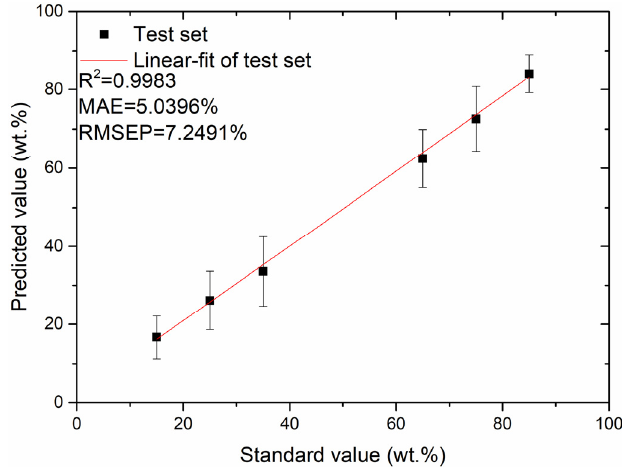
Figure 10. Plot of relationship between the predicted and standard values of the test set based on the LASSO-PLSR-SVR residual correction model. LASSO-PLSR-SVR residual correction